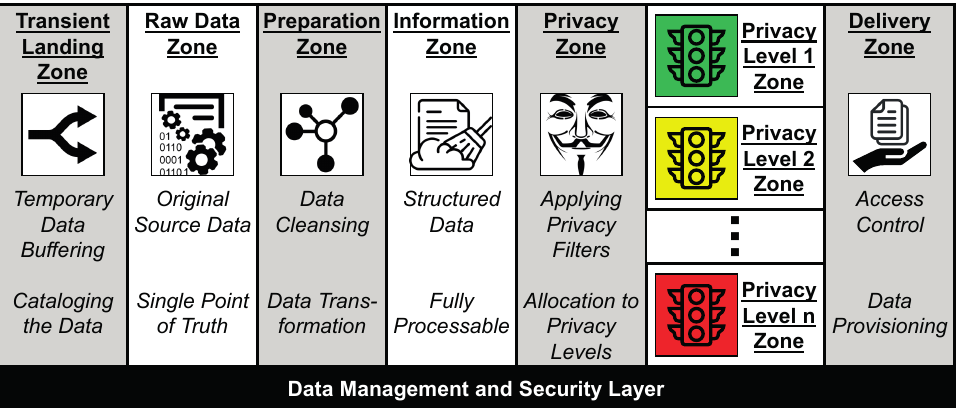
Figure 4. Extended date lake zone architecture to ensure privacy in the data processing phase. This zone architecture reflects the data refinement process. The zones depicted in gray are processing zones in which data are only temporarily held, whereas the zones depicted in white are storage zones in which data are kept persistently. There are storage zones for raw data, information, and